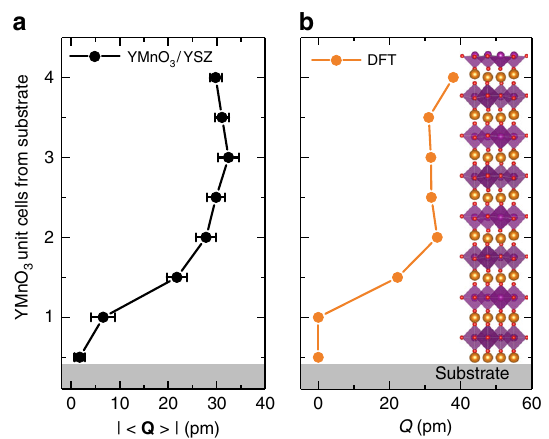
Fig. 3 In fl uence of the substrate- fi lm interface on the improper ferroelectricity. a Averaged displacement | 〈 Q 〉 | for each atomic row in the fi rst four unit cells of the HAADF-STEM image in Fig. 2a. The value of | 〈 Q 〉 | is reduced at the substrate interface and saturates at the bulk displacement value after two unit cells. The error bars are given by the standard error of the mean. b Trimerization amplitude Q calculated by density-functional theory (DFT) for a four-unit-cell YMnO 3 fi lm keeping the bulk-lattice parameters and assuming a clamped ( Q = 0) unit cell toward the substrate interface and a free top surface. The amplitude displays a progressive build up over the thickness of the fi lm and saturates after two-unit cells. The inset in b shows a schematic of the corresponding crystal structure with atomic positions as calculated by